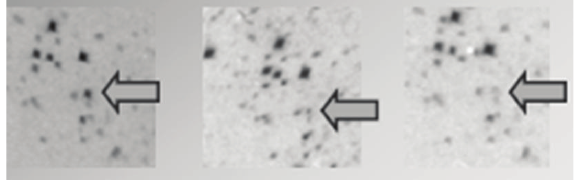
Figure 11: An example of appearance of INTEGRAL sources in optical light as variable objects. IGR J12349-6434 = RT Cru (hard X-ray symbiotic star) in optical light on Leiden Franklin Adams Plates. The object exhibits violent (amplitude 3 magnitudes) optical brightness variations.